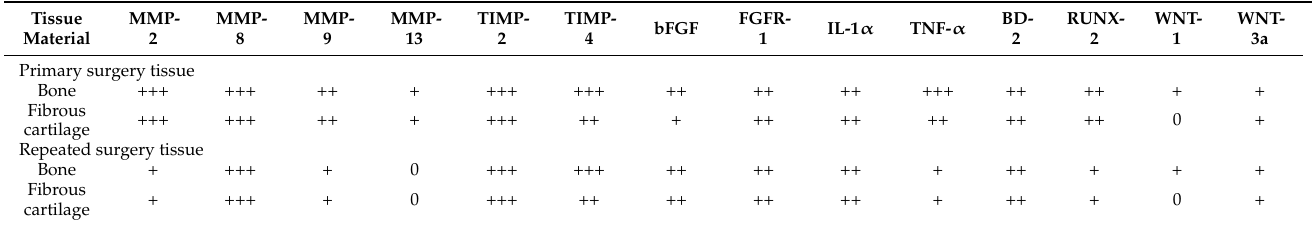
Table 2. Immunohistochemical (semi-quantitative) grading of various tissue factors visualized in the ankylotic fibrous cartilage and bone tissue.